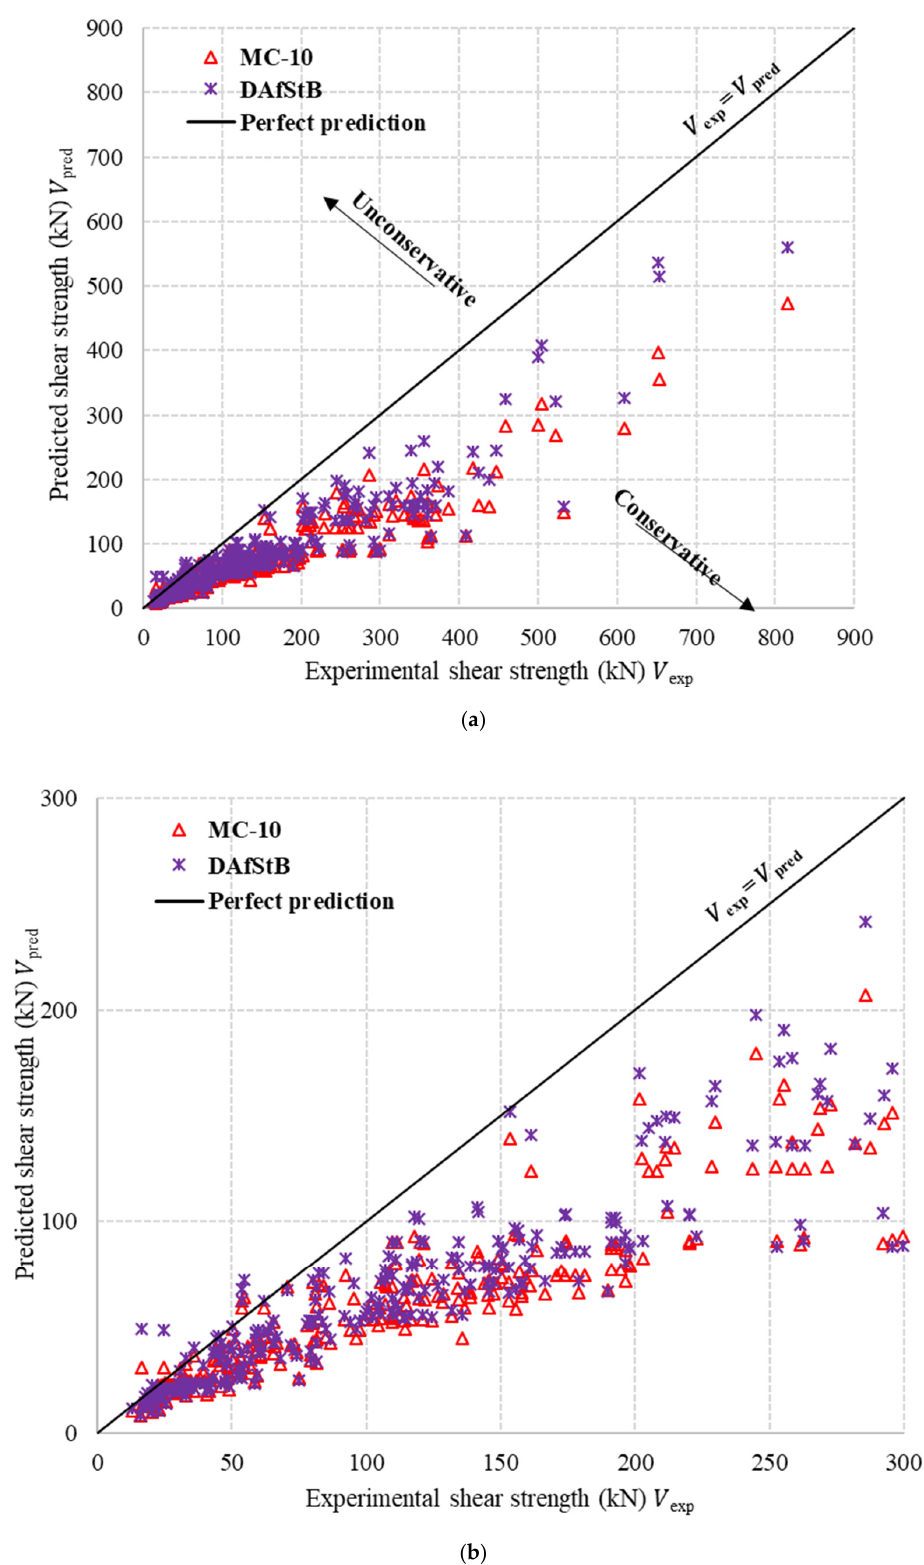
Figure 2. ( a ) Plot of the design shear resistance predictions against experimental observations. ( b ) Plot of the design shear resistance predictions against experimental observations (resistance up to 300 kN only).